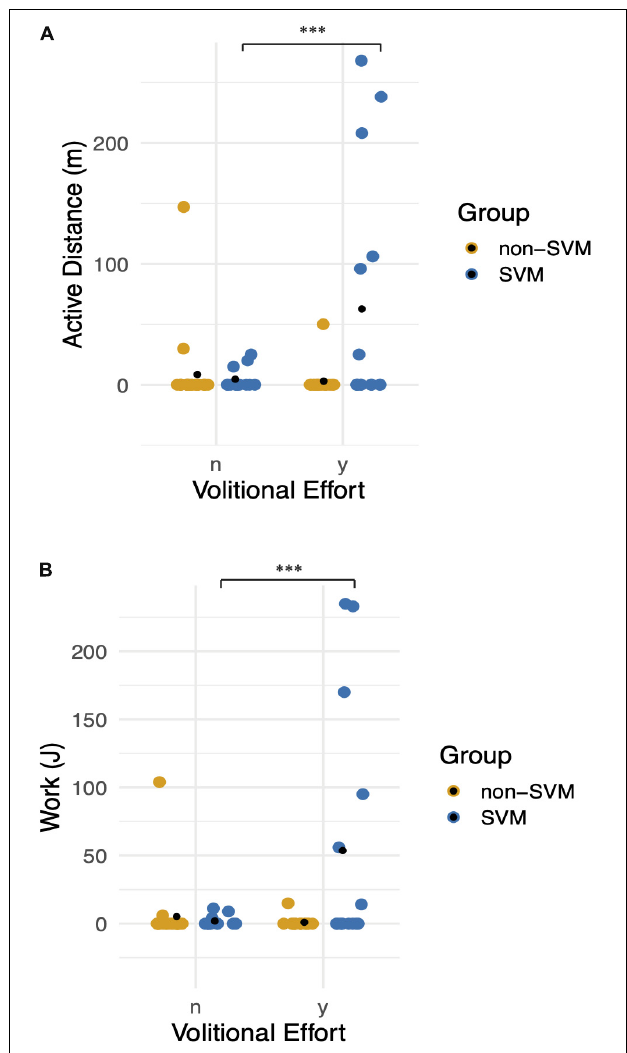
FIGURE 9 | Functional movement without stimulation: graphs demonstrate differences between Groups (0: non-SVM group and 1: SVM group) and between volitional effort ( n = no effort, y = with effort). Means are symbolized by black points. (A) Distance traveled without assistance of the bicycle motor is plotted, when correcting for zero inflated data. There is a significant positive effect on distance when participants from the SVM group attempted to pedal. (B) Pedaling work exerted is plotted, when correcting for zero inflated data. Participants in the SVM group significantly achieved greater work when they provided effort compared to the non-SVM group. *** refers to a p -value of <